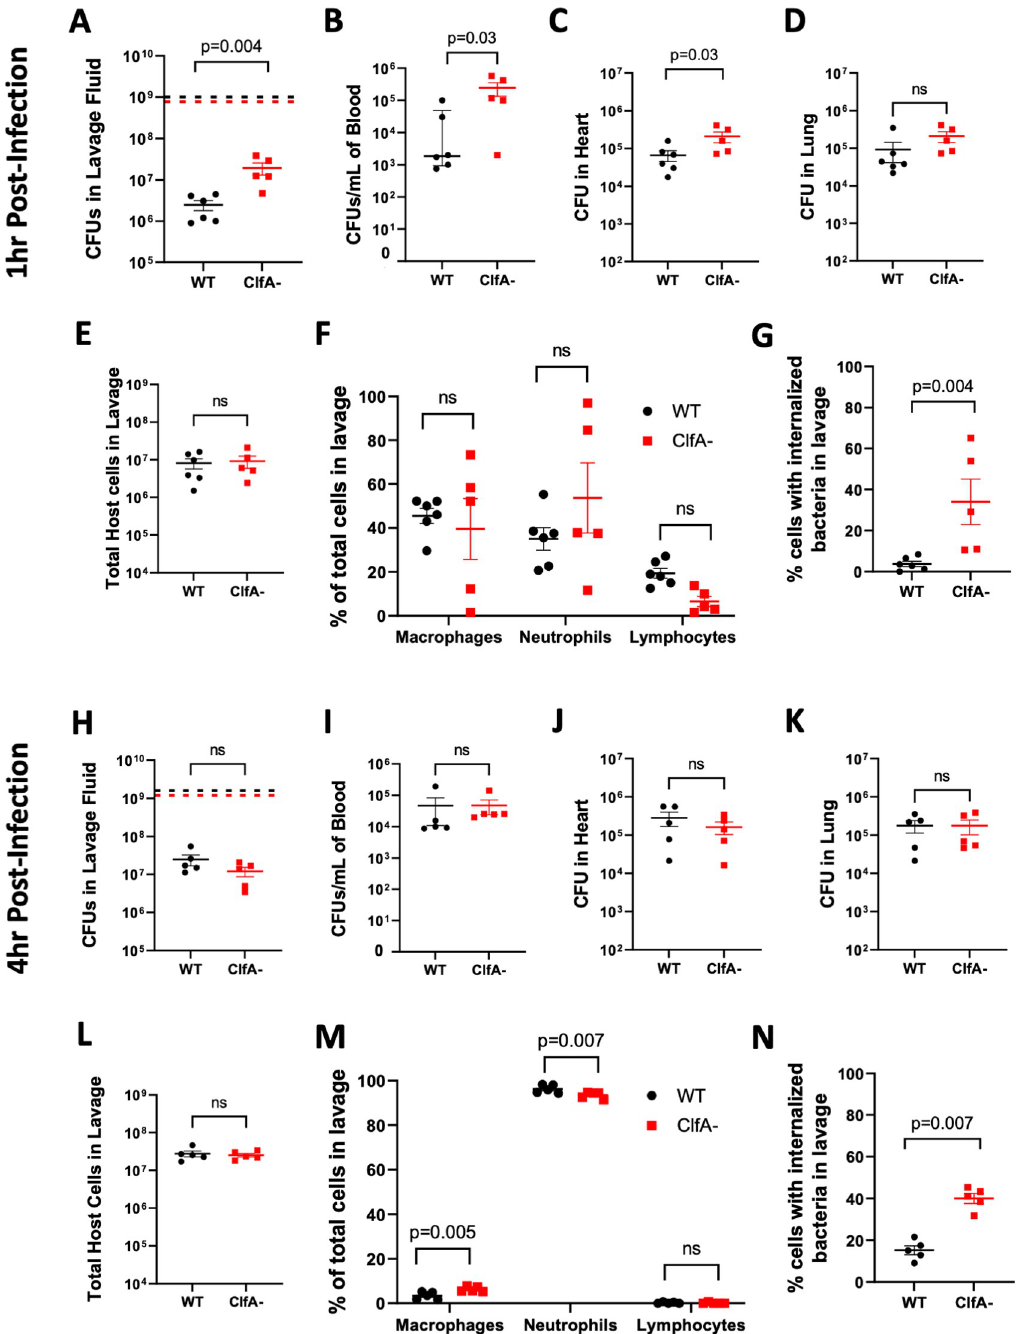
Fig 6. Deletion of ClfA from S. aureus USA300 results in increased S. aureus CFUs in the peritoneal cavity and a transient increase in CFUs the bloodstream and distant organs. Total live bacteria in (A) lavage, (B) blood, (C) heart and (D) Lung of WT mice 1 hour after i.p. infection with WT (1x10 9 CFUs) or ClfA- (7.8x10 8 CFUs) S . aureus USA300. (E) Total host cells, (F) host cell differentials, and (G) and percentage of host cells with internalized bacteria in lavage fluid at 1 hour after infection. Total live bacteria in (H) lavage, (I) blood, (J) heart and (K) lung of WT mice 4 hours after i.p. infection with WT (1.6x10 9 CFUs) or ClfA- (1.2x10 9 CFUs) S . aureus USA300. (L) Total host cells, (M) host cell differentials, and (N) and percentage of host cells with internalized bacteria in lavage fluid at 1 hour after infection. CFU data are presented as mean ± SEM and statistical significance was determined by Mann-Whitney u-test. Host cell counts and percentages are presented as mean ± SEM with statistical significance determined by 2-way ANOVA with Sˇı´da´k’s multiple comparisons test. Data on cells with internalized bacteria are presented as mean ± SEM and statistical significance was determined by Mann-Whitney U-test. Dashed horizontal lines indicate the infection